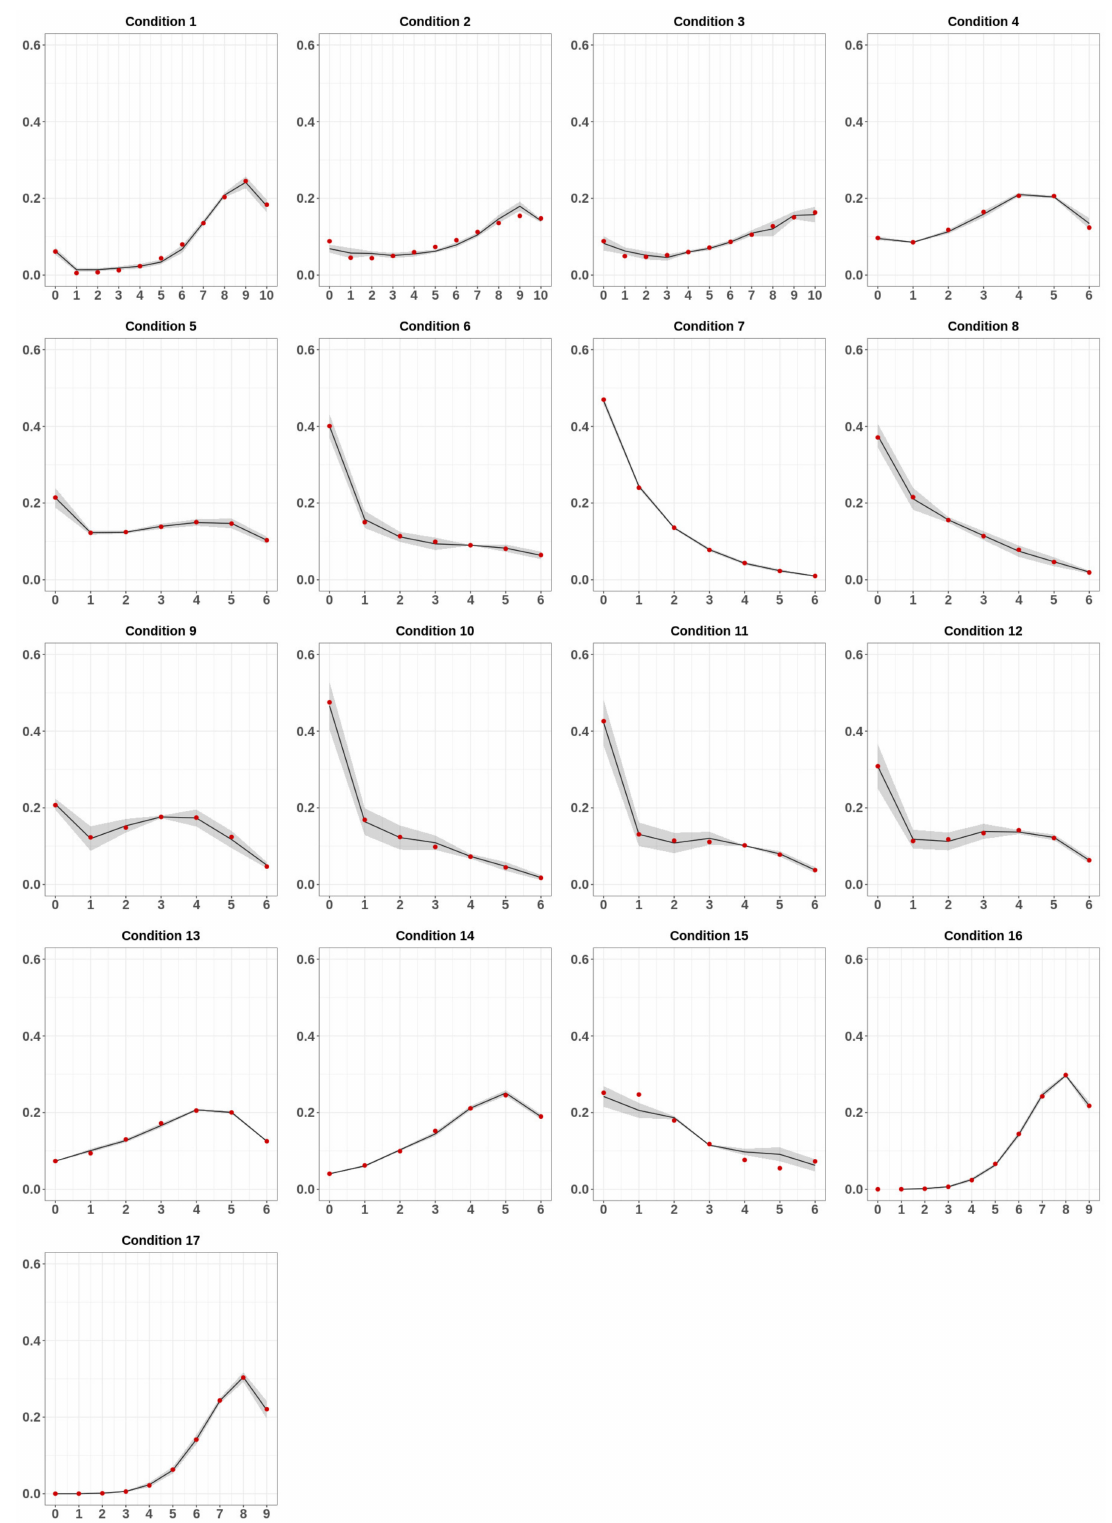
Figure 3. Fit results. For each condition, the experimentally determined average MC frequencies are indicated as red dots. The black lines and the blurred area indicate the average MC frequencies and its respective error predicted by the